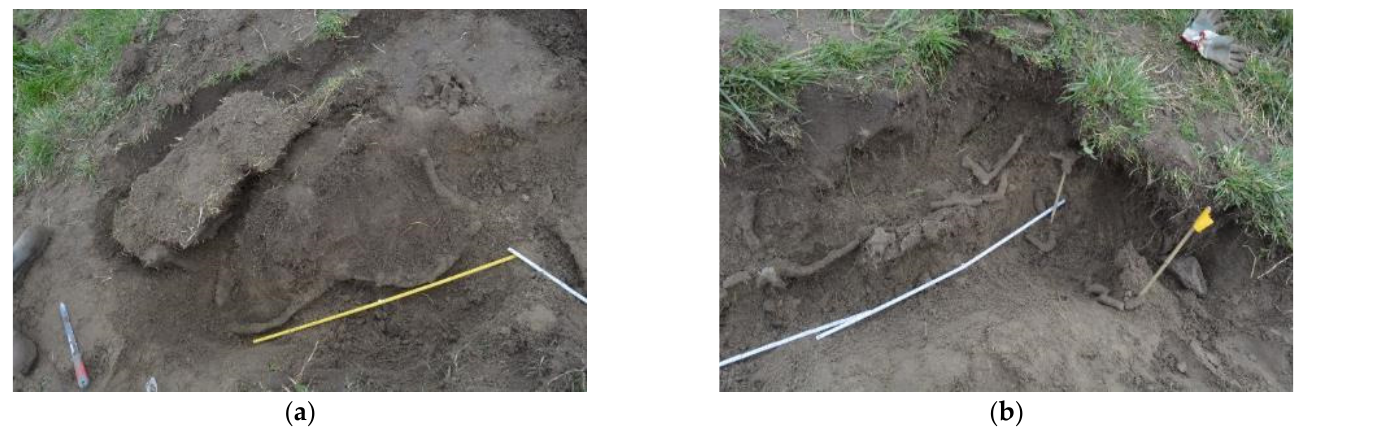
Figure 10. ( a , b ) Examples of excavated grouted animal burrows.